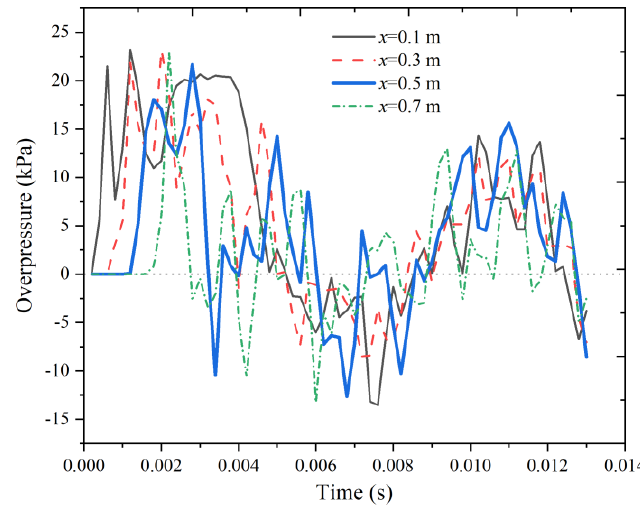
Figure 6. Profiles of the overpressure measured at four different locations.